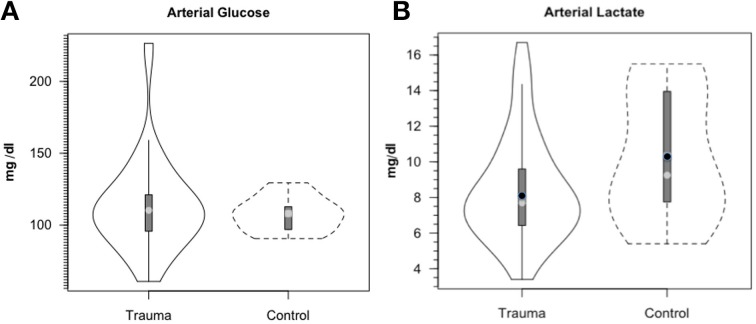
Arterial glucose (A) and lactate concentrations (B) in control and TBI patients. Values were constant over time, so mean values for min 60, 90, and 120 min are shown. Solid lines represent TBI patients (n = 12) while dashed lines are normal control subjects (n = 6). This and subsequent figures depict the following components: median (light circle), mean (dark circle), standard deviation (heavy vertical bar), box-plot whisker (thin vertical bar) and a kernel density estimation of the data distribution (replacing the box-plot's rectangular depiction) following Hintze and Nelson (1998) as visualized by R package “Caroline” (Schruth, 2012). When coincident, the median circle symbol obscures the mean symbol. TBI patients demonstrated arterial glucose and lactate levels similar to those in healthy control subjects. From Glenn et al. (2014).